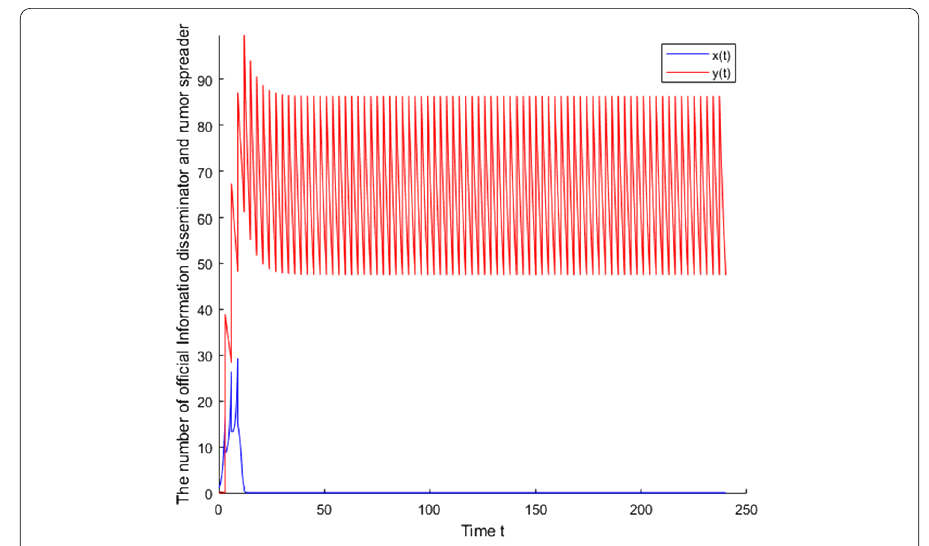
Figure 1 Time-series of the spreader x for eradication and the disseminator y for